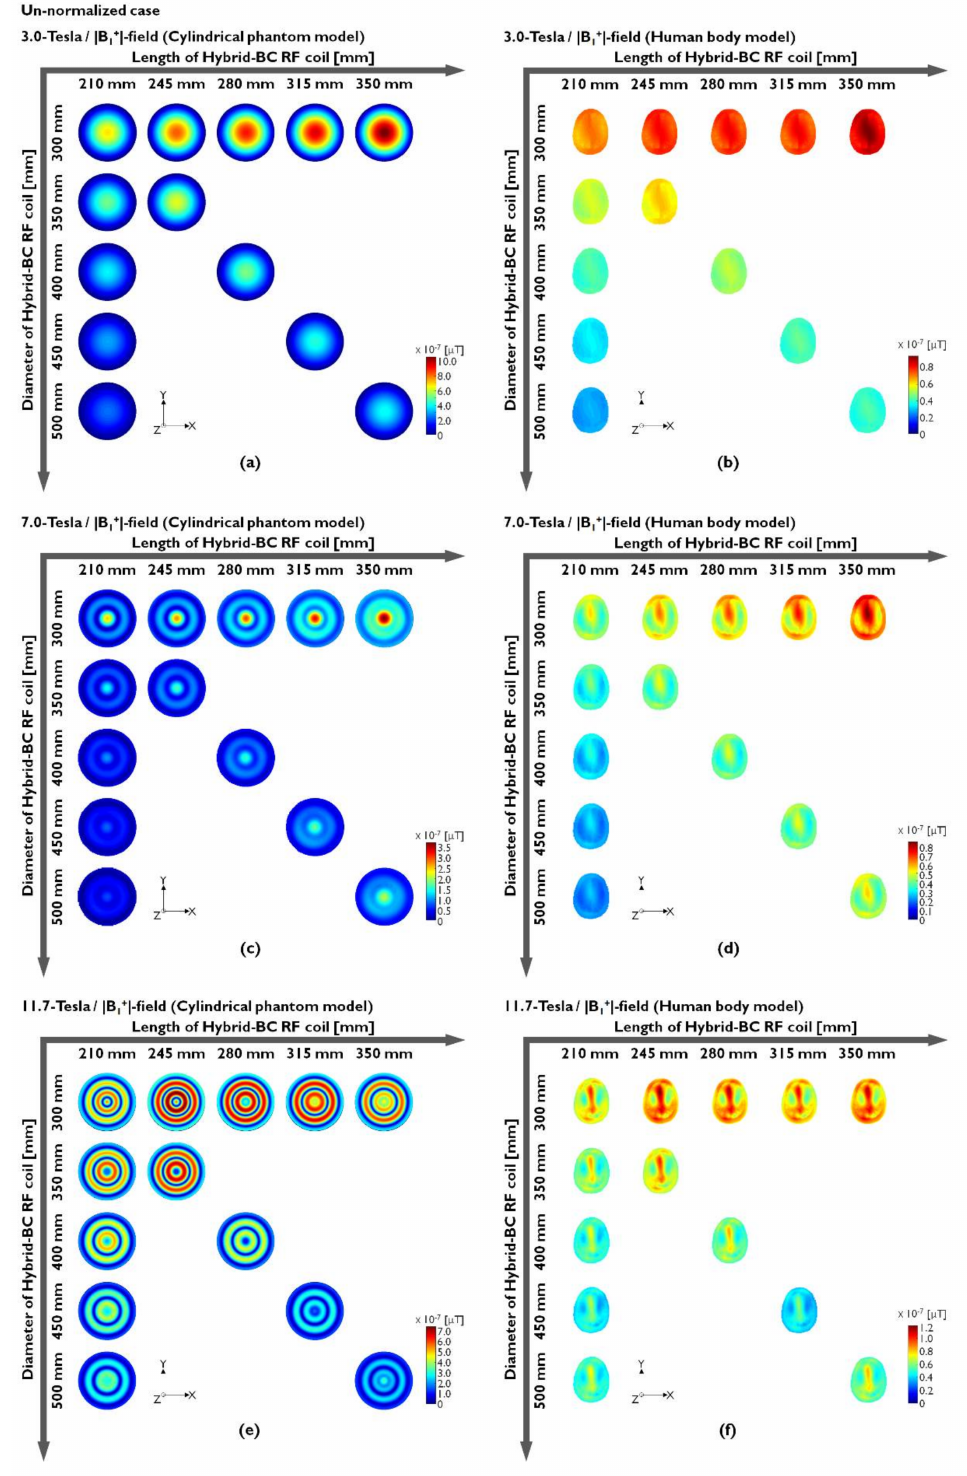
Figure 2. Unnormalized |B 1 + |-field distribution obtained when using a cylindrical phantom model ( a , c , e ) or a human body model ( b , d , f